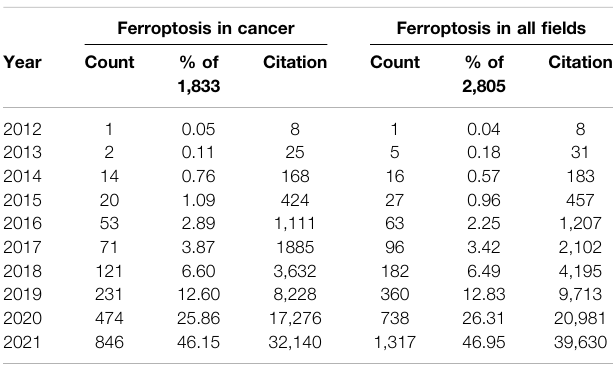
TABLE 1 | The annual number of publications on